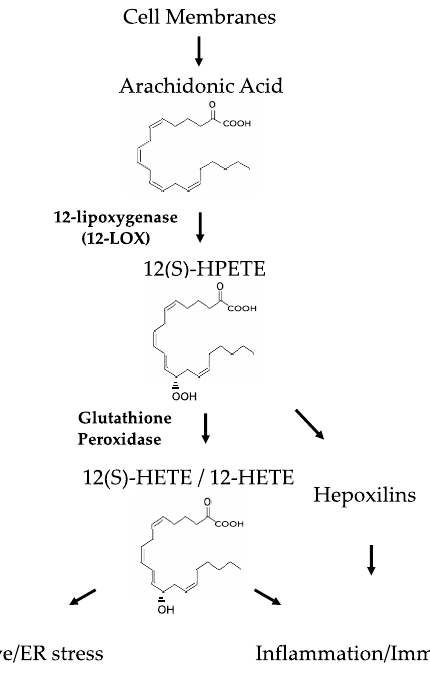
Figure 3. The 12-Lipoxygenase Pathway.